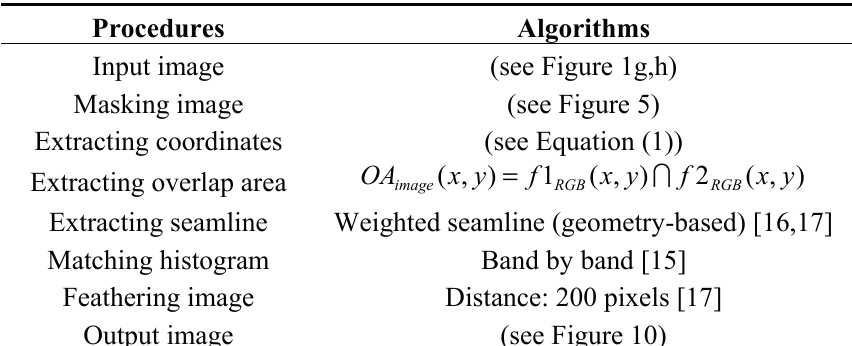
Table 5. Experimental conditions used for performance